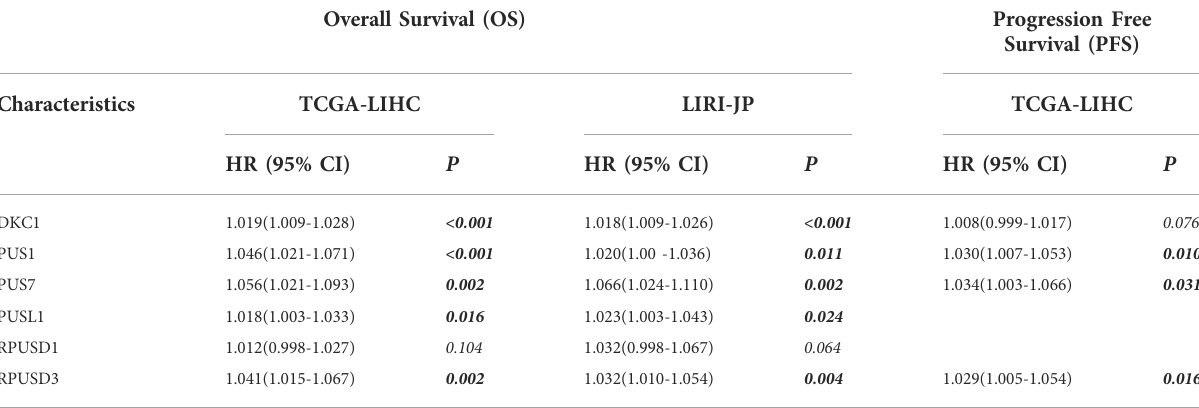
TABLE 2 Results of multivariate Cox analysis for PUSs . Multivariate analysis Overall Survival (OS) Progression Free